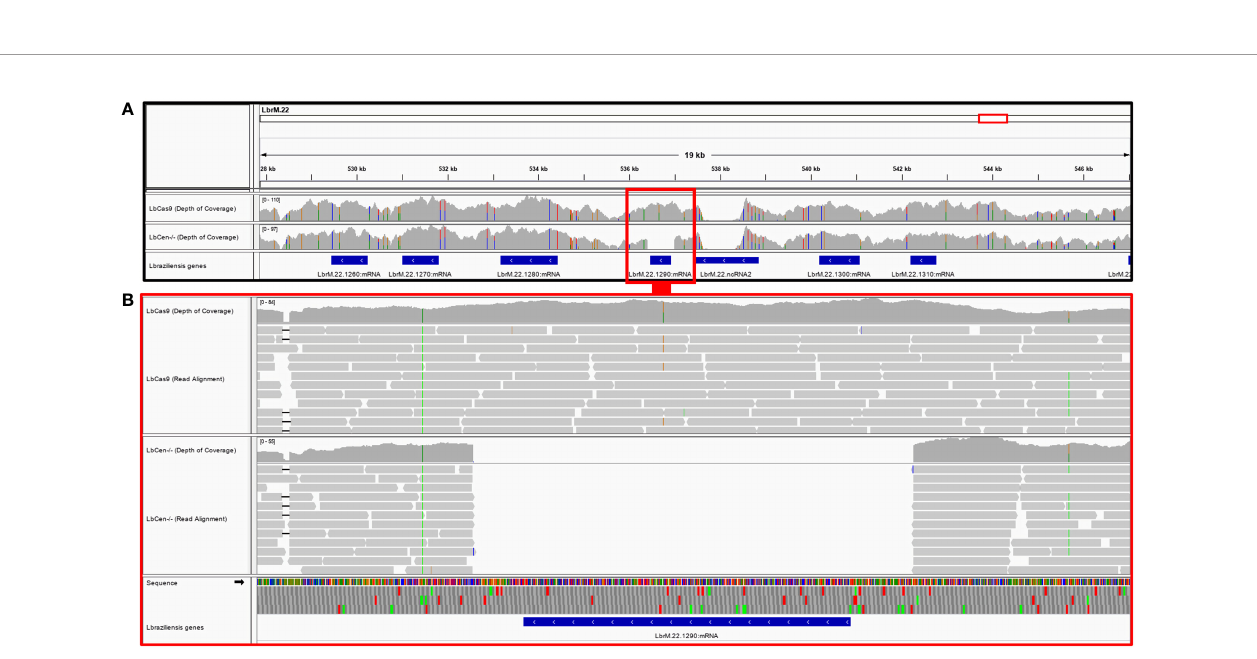
FIGURE 3 | Deletion of the LbrM.22.1290 centrin gene as con fi rmed by whole genome sequencing. (A) MHOM/BR/75/M2904 L. braziliensis chromosome 22 encompassing the 527,855 – 547,147 region covered by LbCas9T7 and LbCen − / − genomic read libraries. Blue boxes represent L. braziliensis genes, drawn in scale; LbrM.22.1290 centrin gene region is highlighted by red box. Gray histograms above the genes represent the read depth in each genomic position for each genomic library, where colored markings denote SNPs in the reads when compared to the reference genome. (B) Read mapping in the genomic region encompassing the LbrM.22.1290 gene. Mapping of individual reads is represented by gray boxes. An expected number of reads mapped into the LbrM.22.1290 centrin gene region in the LbCas9T7 isolate, whereas no read from LbCen − / − library mapped into this